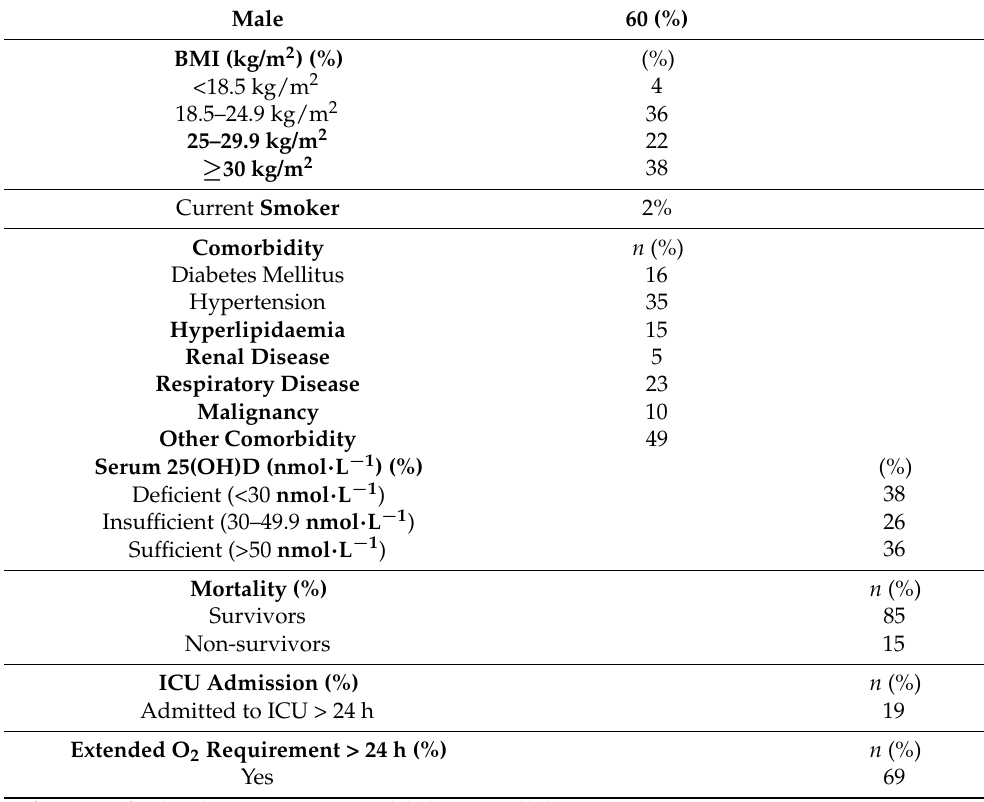
Table 1. Socio-demographic, anthropometric and clinical status of COVID-19 patients ( n = 232). Median age 56 years (range